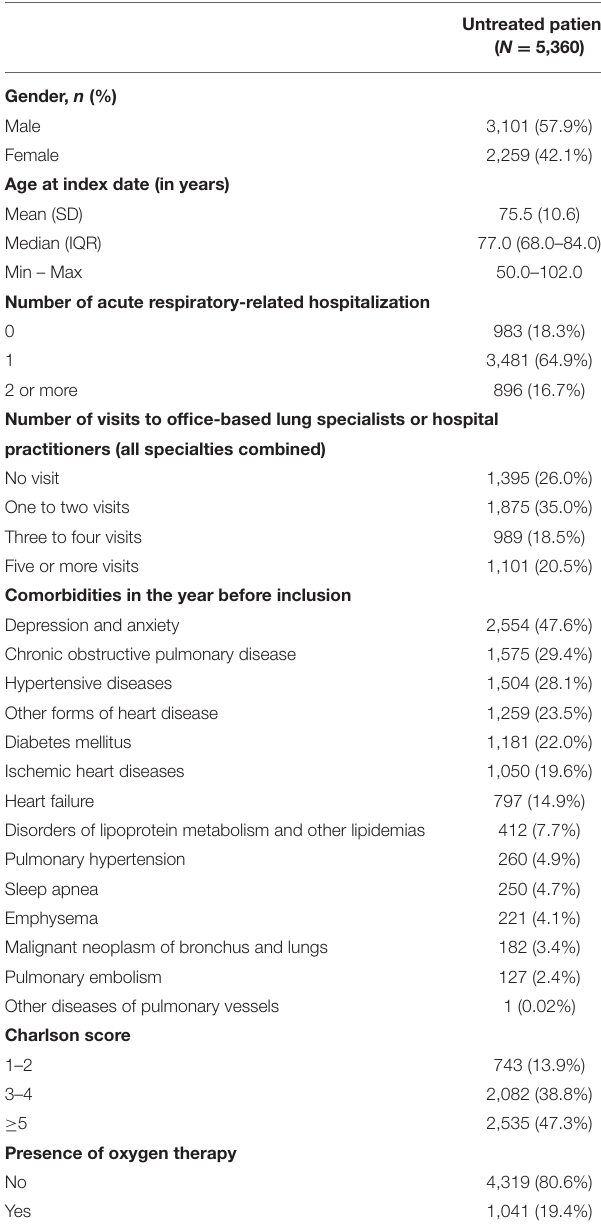
TABLE 1 | Baseline characteristics of IPF